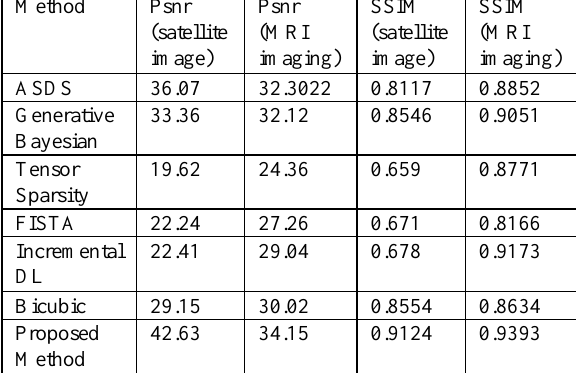
Table 2. Represents the Psnr and SSIM for both images